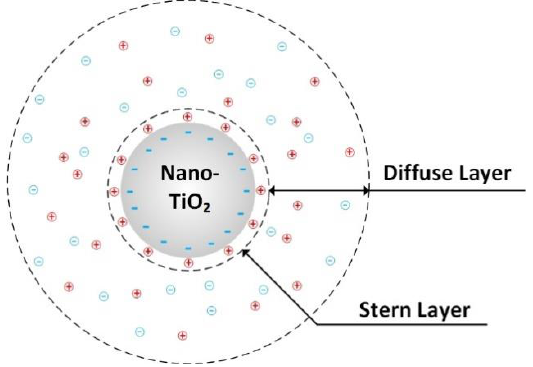
Figure 7. The sketch of electric double layer structure.